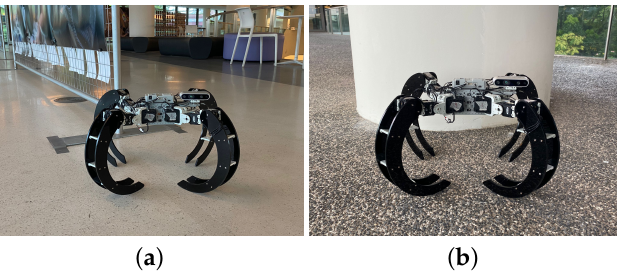
Figure 9. Crawling locomotion mode. ( a ) On smooth surface. ( b ) On rough surface.